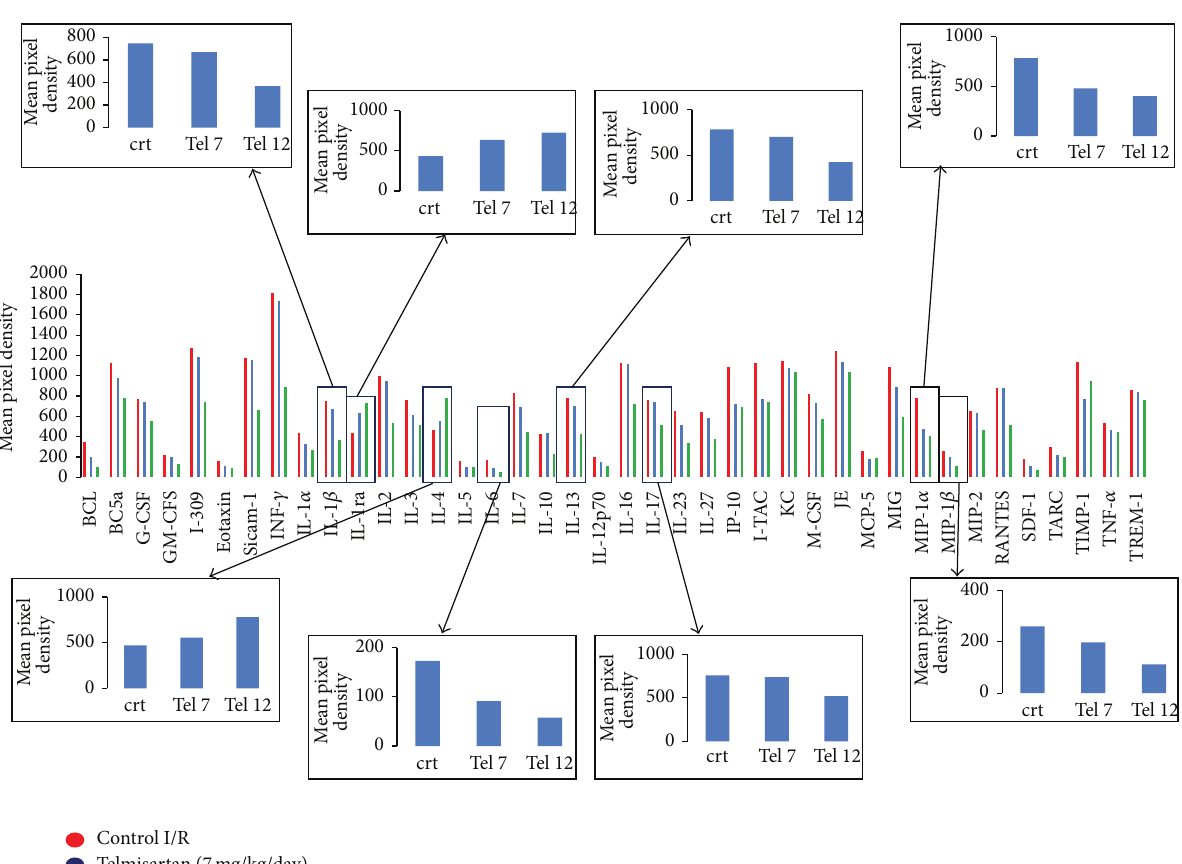
Figure 5: Changes caused by telmisartan (7 and 12mg/kg) on some inflammatory and anti-inflammatory cytokines and chemokines.